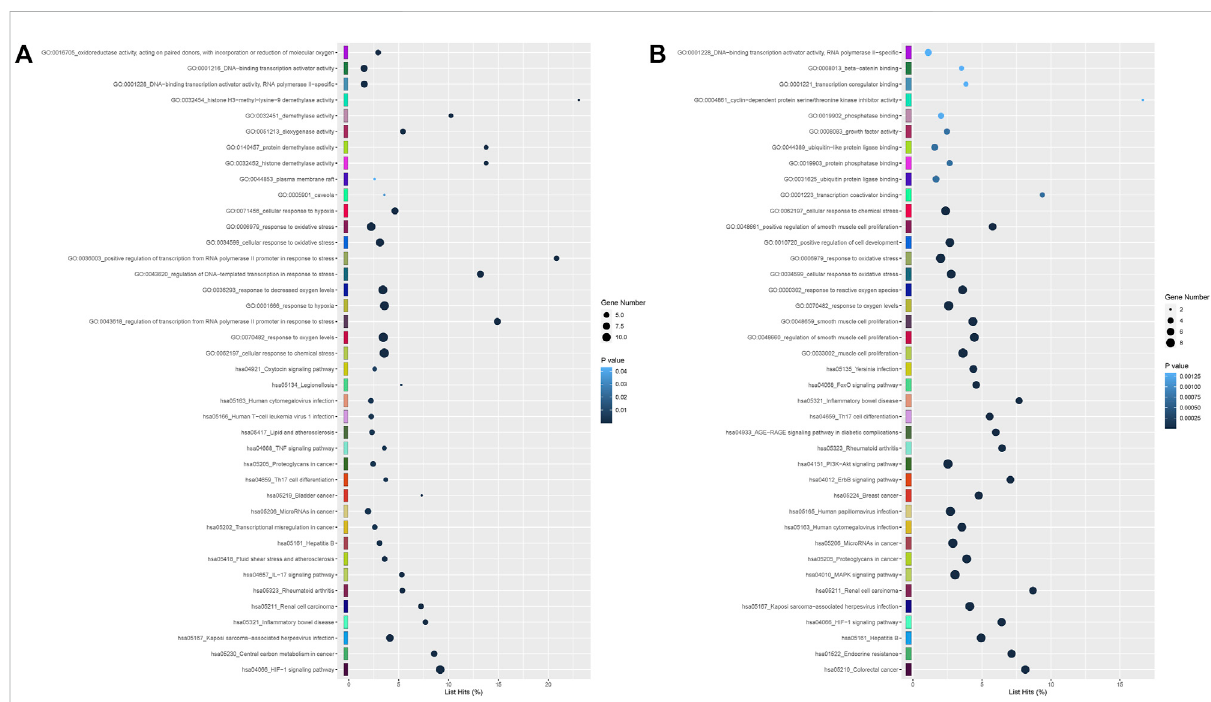
FIGURE 6 (A) GO including biological process, cellular components and molecular function analysis, and KEGG enrichment analysis of hub differentially expressed at 4 h after genes oxygen-glucose deprivation. (B) GO and KEGG enrichment analyses of differentially expressed hub genes at 8